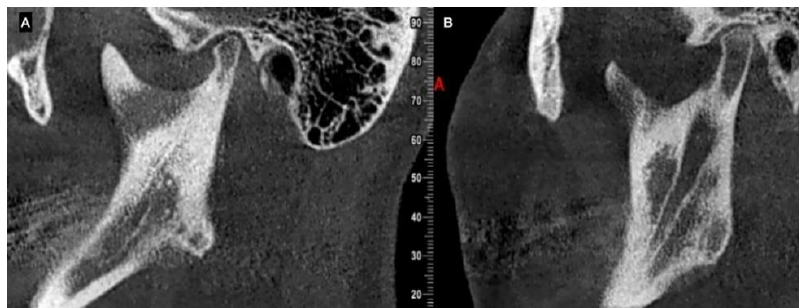
Figure 4. CBCT of the same subject in sagittal view. ( A ) left condyle in normal growth and ( B ) right condyle with hyperplastic growth involving neck and ramus of the same side of the mandible. The progressive asymmetry will move all the sides involved in the abnormal growth of the condyle.